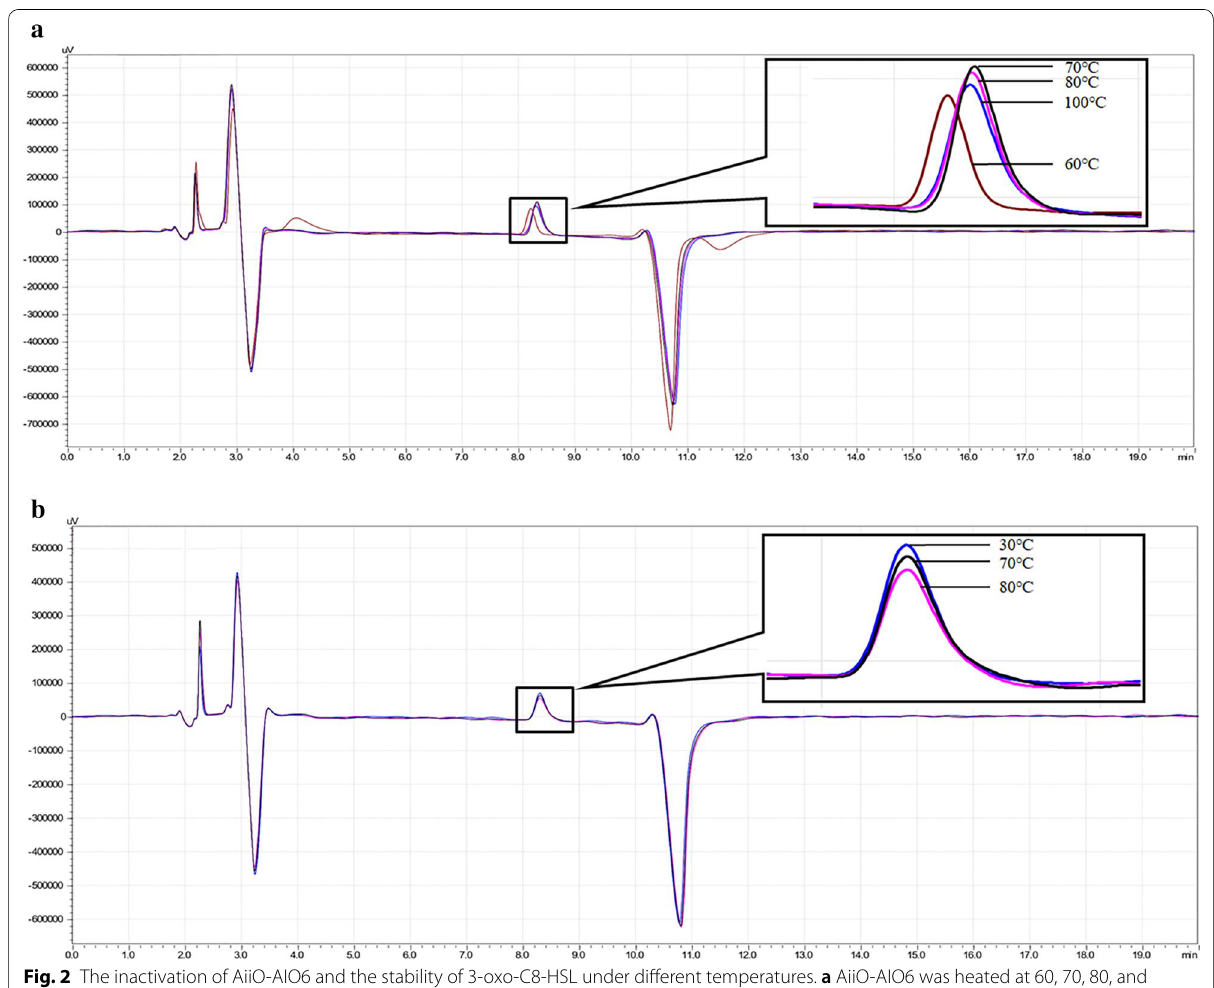
Fig. 2 The inactivation of AiiO‑AIO6 and the stability of 3‑oxo‑C8‑HSL under different temperatures. a AiiO‑AIO6 was heated at 60, 70, 80, and 100 °C (as control with 100% inactivation rate) for 10 min and then reacted with 3‑oxo‑C8‑HSL at 30 °C for 20 min. The reaction products were analyzed by HPLC to quantify 3‑oxo‑C8‑HSL. b 3‑oxo‑C8‑HSL solution was treated at 30 (as control with 0% lactonolysis rate), 70 and 80 °C for 10 min then detected directly by HPLC to quantify